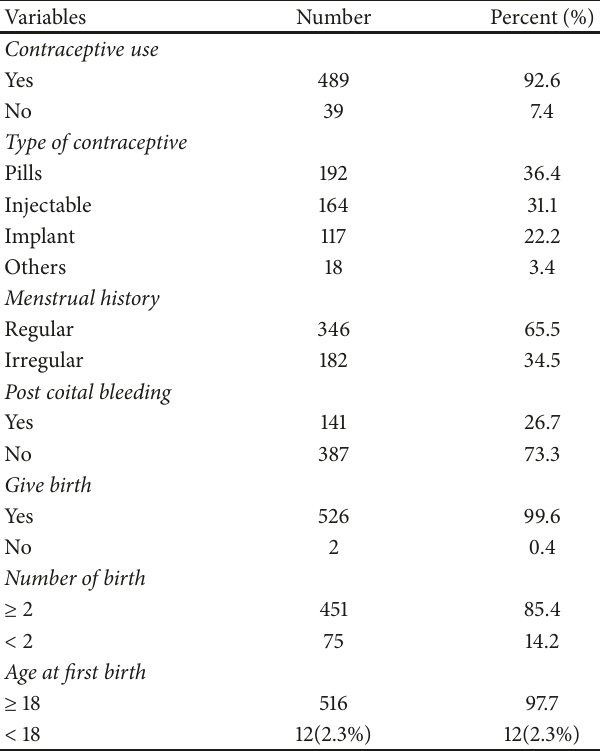
Table 2: Reproductive related characteristics of women screened in Arba Minch town and zuria district, Gamo Gofa Zone, SNNPR, Ethiopia,